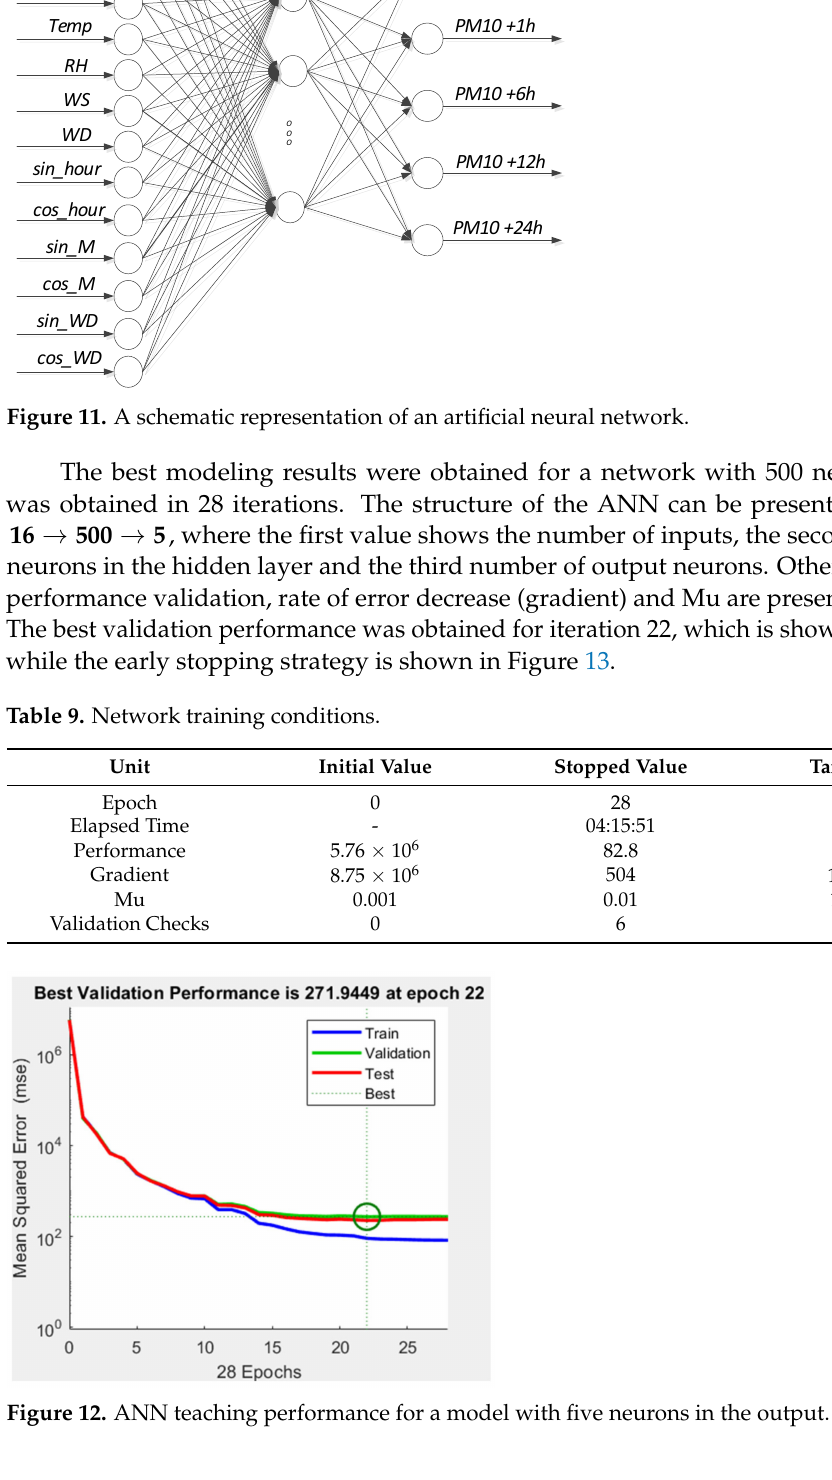
15 of 24 Figure 10. Comparison of the actual data and the data obtained by prediction.